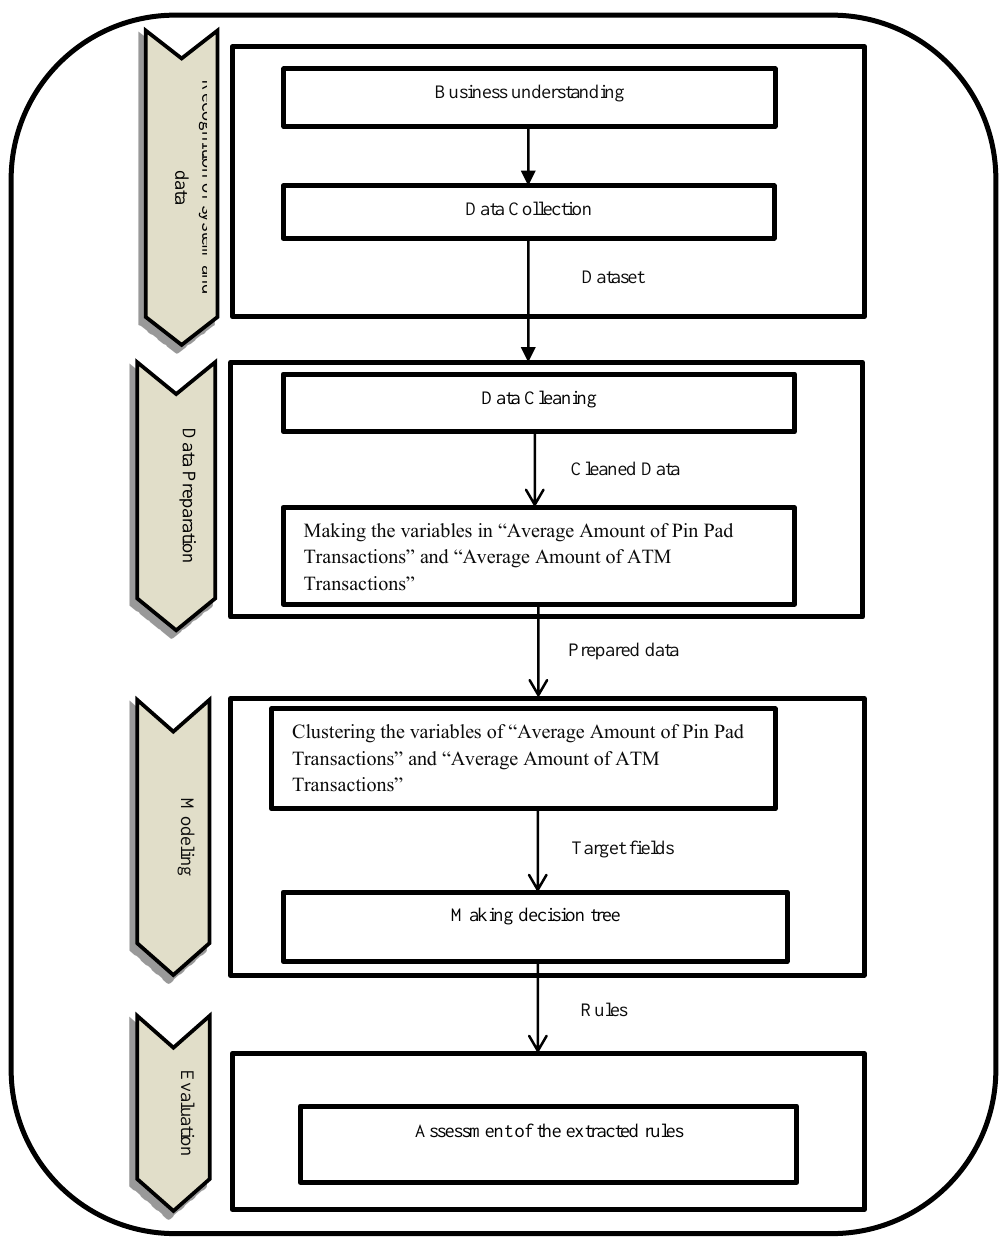
Figure 2. Proposed process for this